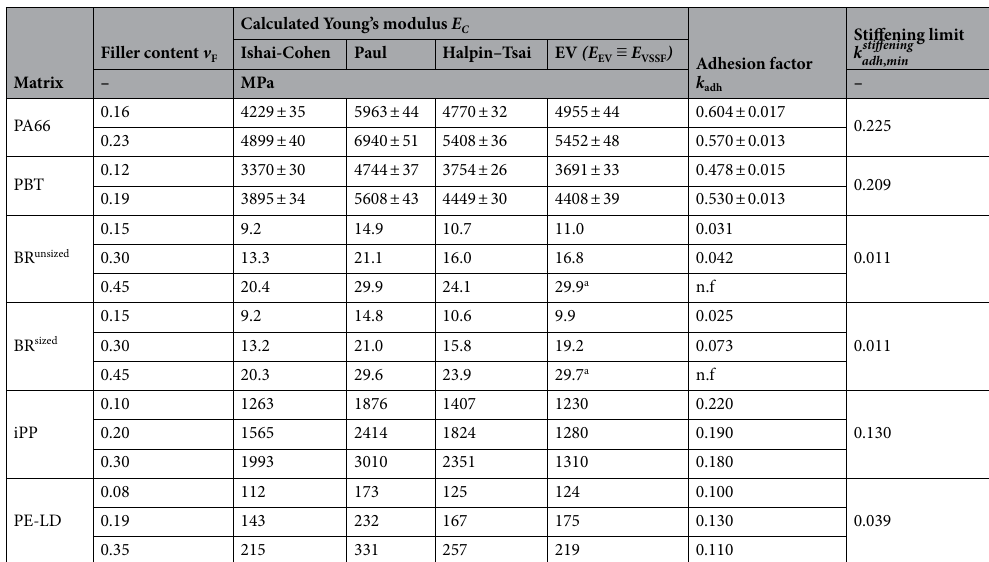
√ stiffening = E M / E F . a To calculate E adh , min EV the adhesion factor was set to k adh = 1.